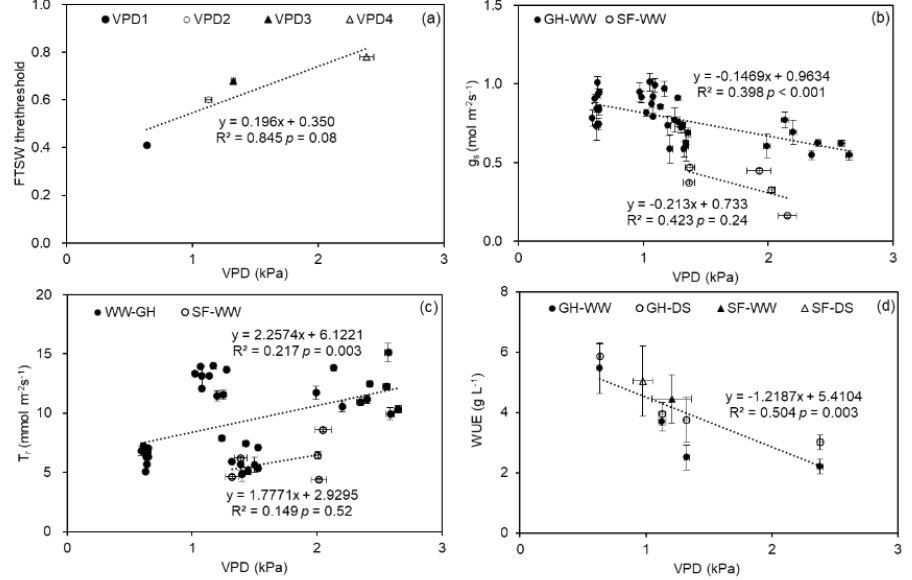
Figure 6. Relationship between vapor pressure deficit (VPD) and fraction of transpirable soil water ( FTSW ) threshold in the greenhouse cells ( a ), stomatal conductance ( g s ; ( b )), and transpiration rate ( T r ; ( c )) of well-watered (WW) potato plants grown in the greenhouse (GH) and field (SF), as well as their water use efficiency ( WUE ; ( d )). The regression line is accompanied by an equation, significance level ( p -value), and coefficient of determination (R 2 ). Error bars indicate the standard error of the mean ( n = 3 or